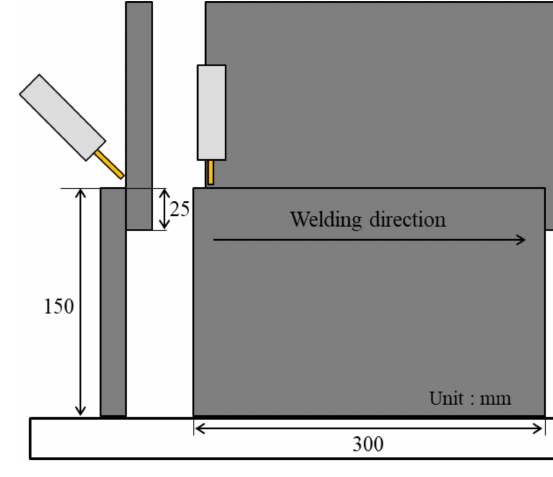
Figure 1. Welding joint geometry. Table 3. Welding conditions applied in this